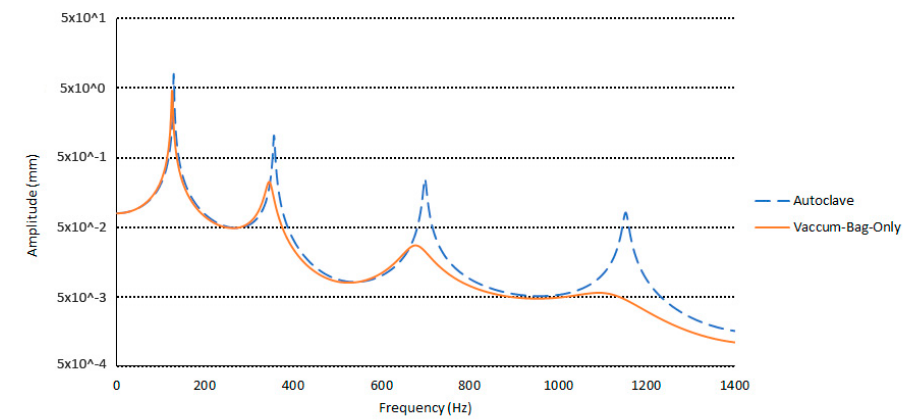
Figure 13. Maximum amplitudes recorded on the different CFRE plates by frequency sweep excitation for 0 < 𝑓 < 1400 Hz .